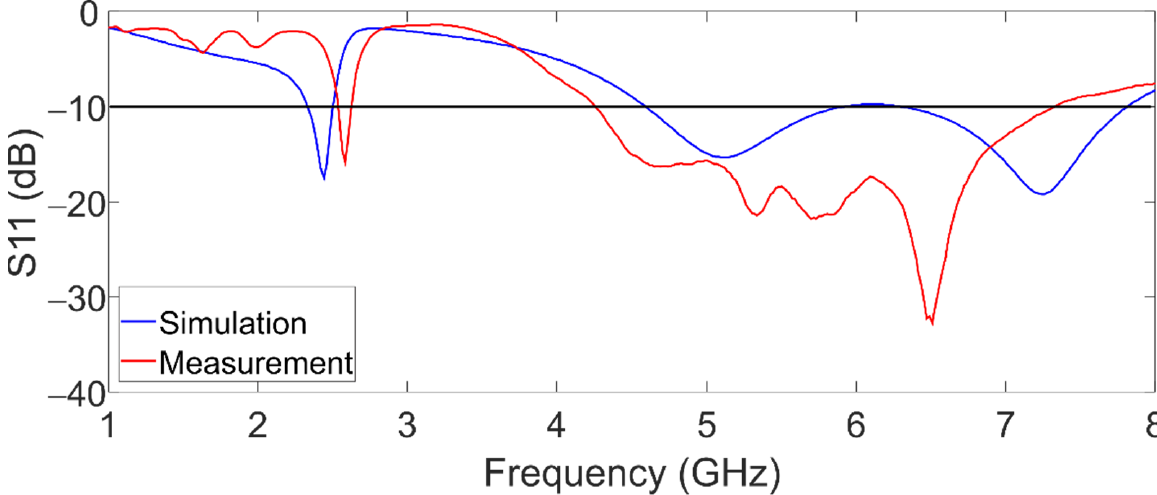
Figure 7. Simulated and measured reflection coefficient of the dual-band graphene antenna. Table 3. Frequency ranges and fractional bandwidth of the dual-band graphene antenna. Frequency